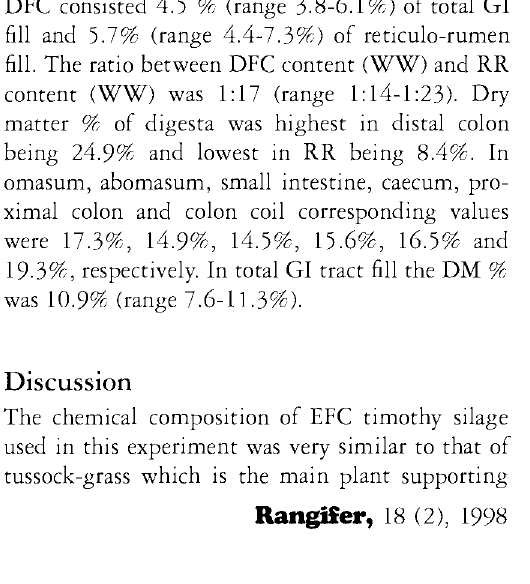
Fig la. Live body mass (BM; days 1-untill slaughtered) development of five reindeer calves (animals A (A), B (•), C (•), D (*) and E (•)) fed early harvested first cut timothy silage (Phleum pratense). Fig lb. Feed intake (kg dry matter (DM)/day; median and range; days 1-77) of five reindeer calves. The feeding experi ment started 24 November, 1994 (day